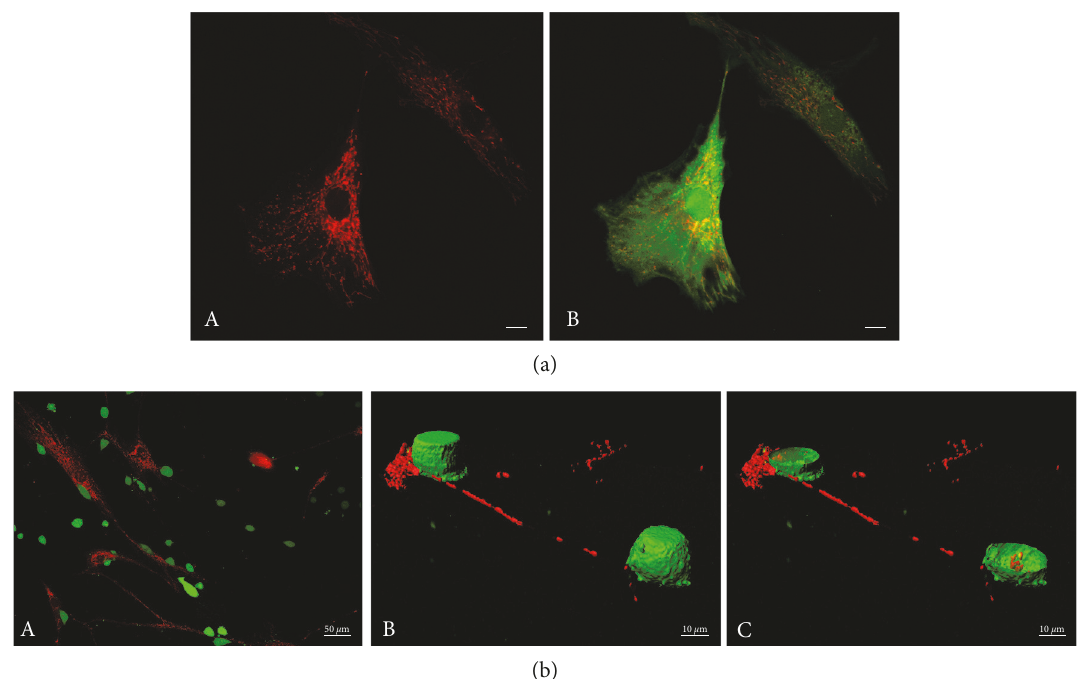
Figure 2: Mitochondrial tra ffi cking from MSCs to MDA-MB-231 breast cancer cells. (a) MSC mitochondrial network. MSCs were labeled by MitoTracker Deep Red FM and Green CellTracker CMFDA. Scale bars, 10 μ m. (b) Transfer of MSC mitochondria to MDA-MB-231 cells. Coculture (24 h) of human MSCs (MitoTracker Red CMXRos prestained) and MDA-MB-231 cells (Green CellTracker CMFDA prestained). (A) 2D view of the coculture, (B, C) 3D reconstruction of the cells from stacks of confocal images with the cell isosurface view (B), and xy plane section (C) (Imaris). Scales, (A) 50 μ m, (B, C) 10 μ